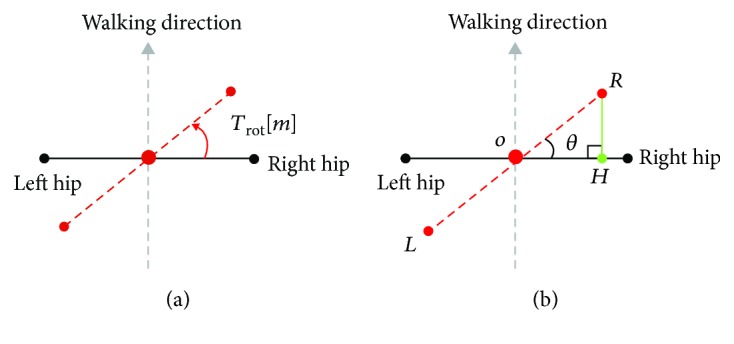
Definition of hip rotation angle Trot: Trot in (a) equals the included angle θ of the right triangle ∆ROH in (b).